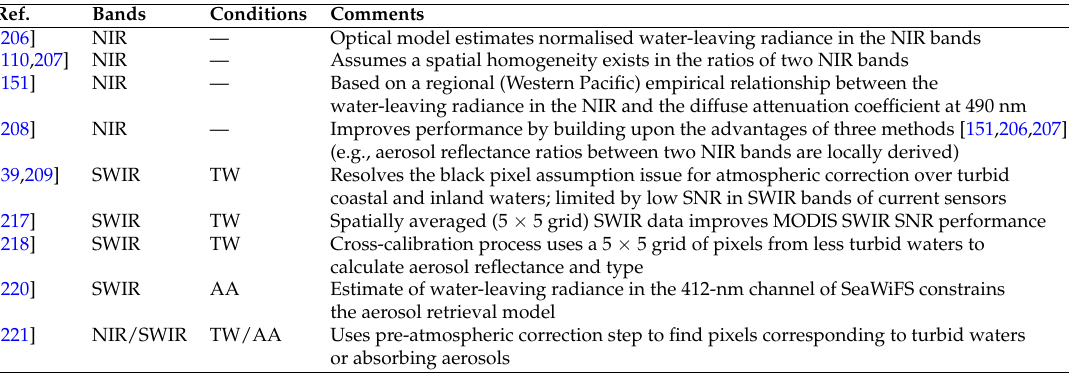
Table 2. Black pixel assumption approaches for atmospheric correction. These atmospheric correction methods make an assumption of zero water-leaving radiance in specific bands. Values in these bands are taken as an estimate of the atmospheric contributions to the top-of-atmosphere signal. (Key. Bands: bands assumed black; NIR, near infrared; SWIR, shortwave infrared. Conditions: conditions the method can handle in addition to the open ocean; TW, turbid waters; AA, absorbing aerosols; SNR, signal-to-noise ratio; MODIS, Moderate Resolution Imaging Spectroradiometer; SeaWiFS, Sea-viewing Wide Field-of-View